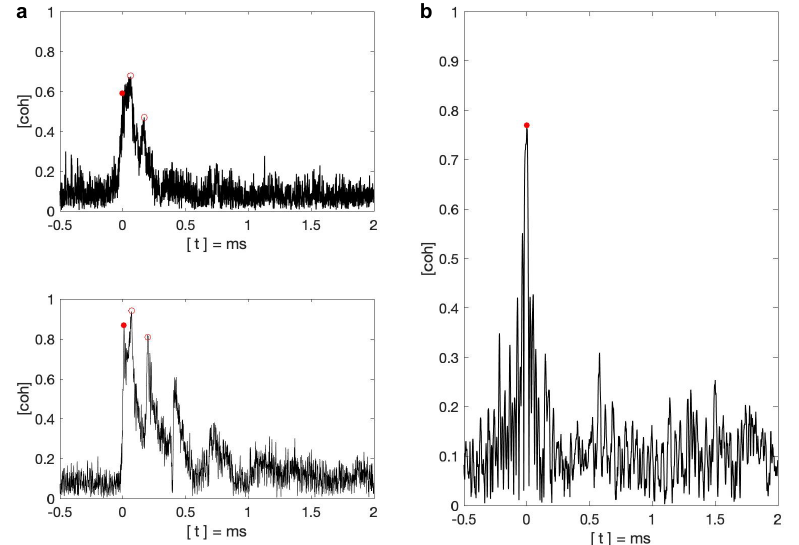
Figure 6. ( a ) Coherency waveforms used in the simulation with 105 receiver network. Calculated coherency waveform of the selected individual events ( upper ) and the coherency waveform of 1150 km from the coherency waveform bank ( bottom ). The ground wave maxima are marked with red dots, and the skywave maxima are marked with red open circles. ( b ) The coherency waveform calculated by the filtered waveforms. The maximum is marked with a red